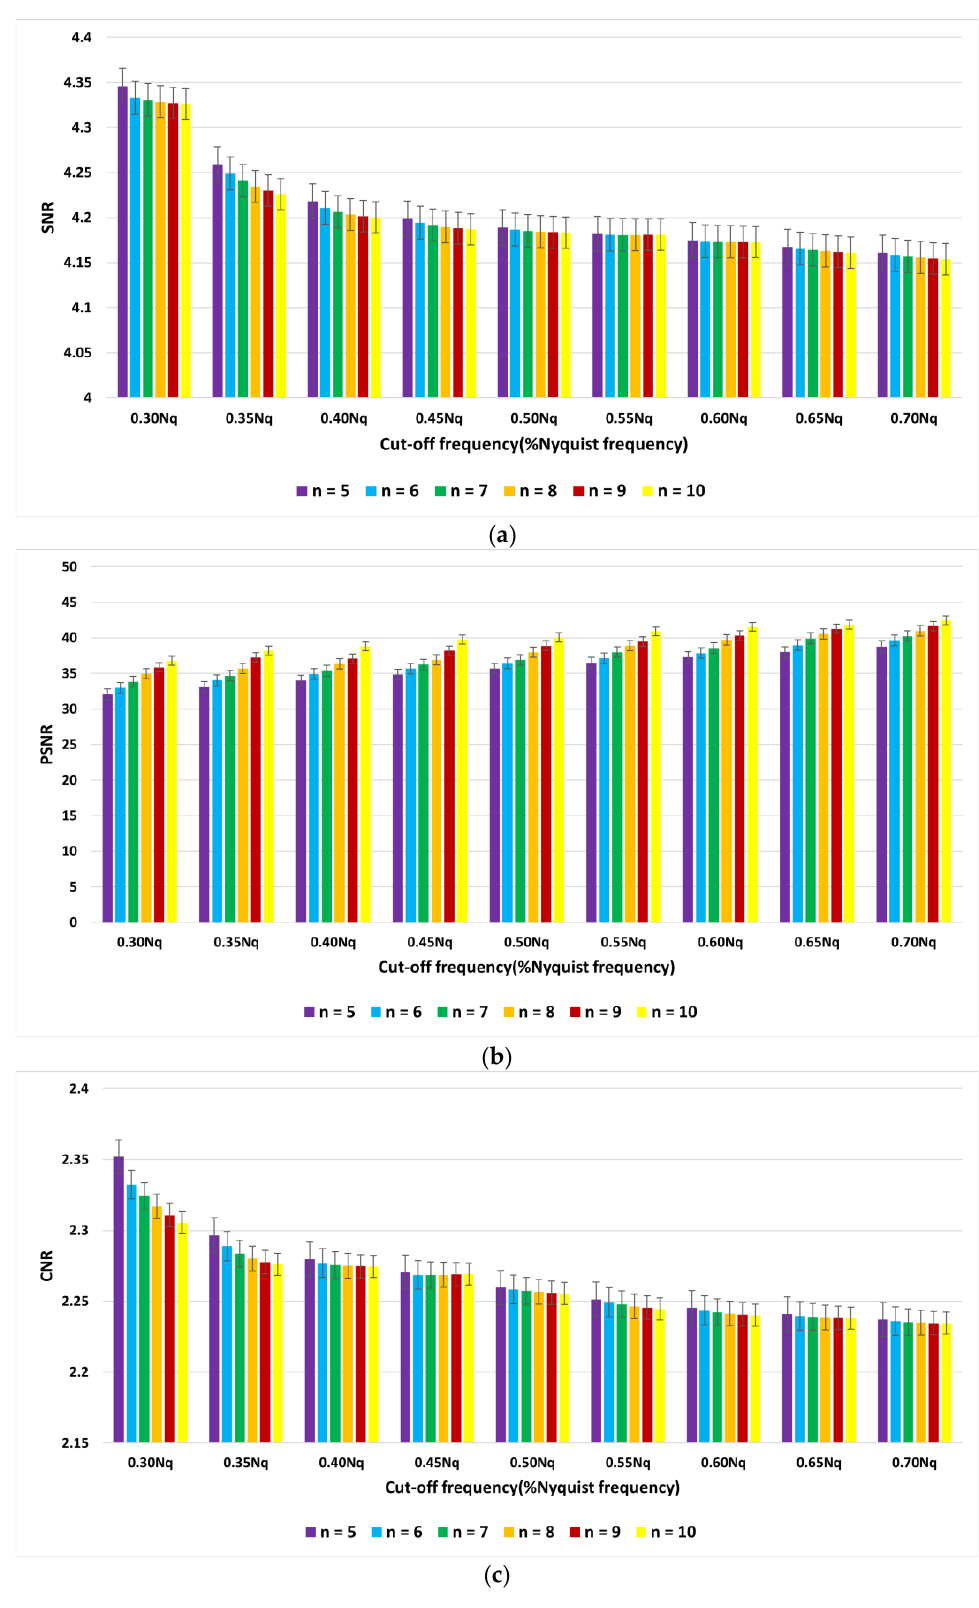
Figure 6. Graph of average of ( a ) signal-to-noise ratio (SNR), ( b ) peak signal-to-noise ratio (PSNR), and ( c ) contrast-to-noise ratio (CNR) using the Butterworth filter.